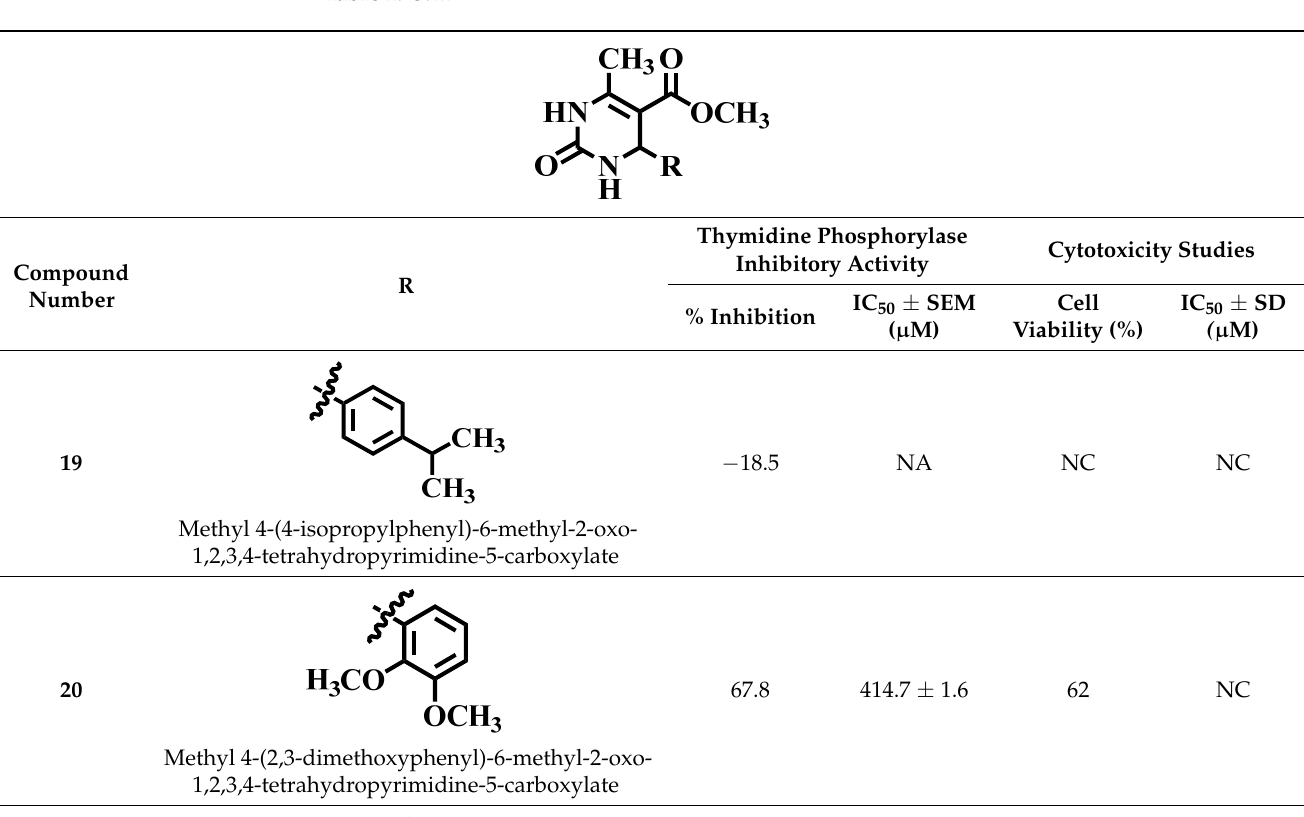
Table 1. Thymidine phosphorylase (TP) inhibitory activity of dihydropyrimidone ( 1 – 40 Table 1. Cont.